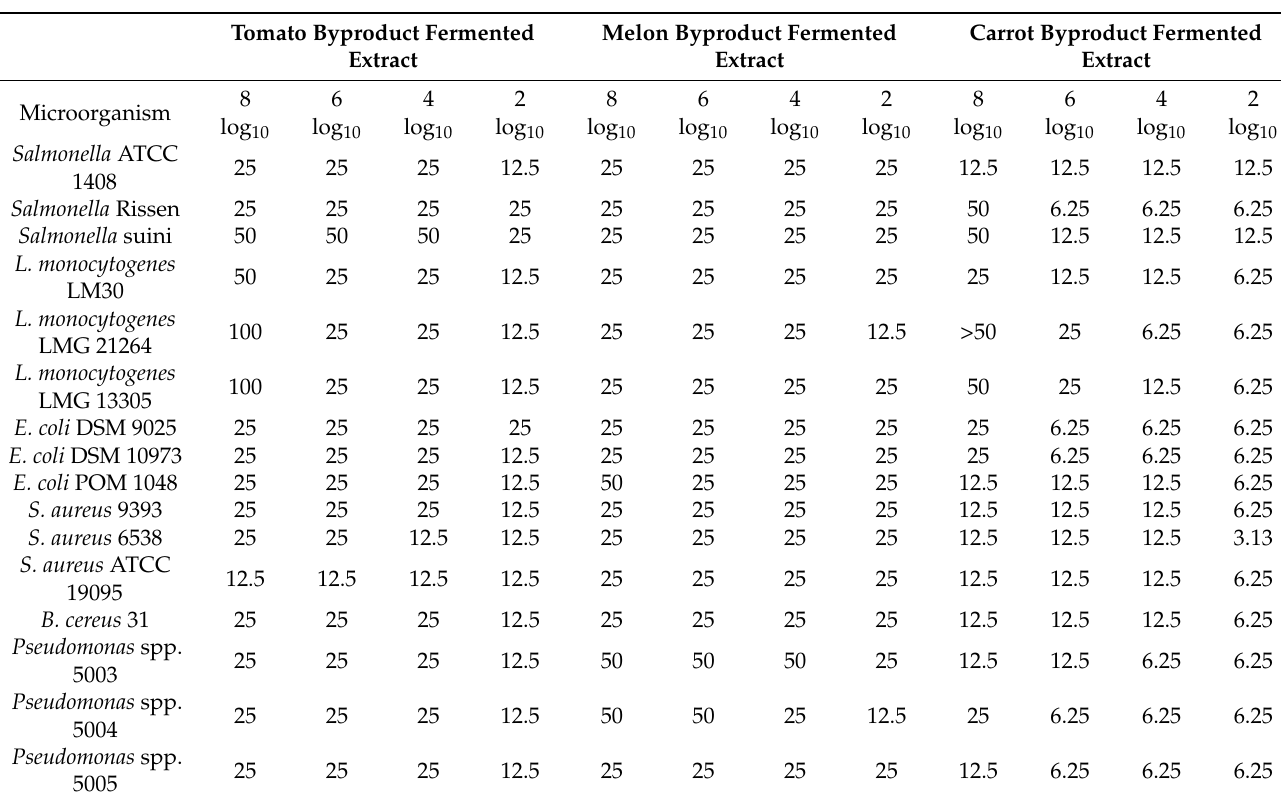
Table 1. Minimum bactericidal concentration (MBC) of fermented tomato, melon, and carrot byproduct extracts (mg/mL) on Salmonella spp., L. monocytogenes , E. coli , S. aureus , B. cereus , and Pseudomonas spp. Different microbial concentrations were tested for each extract (8, 6, 4, and 2 log 10 CFU/mL) (ATCC: the American Type Culture Collection; DSMZ: Deustsche Samm- lung von Mikroorganismen und Zellkulturen GmbH; BCCM/LMG: the Belgian Coordinated Collection of Microorganisms; NCYC: the National Collection of Type